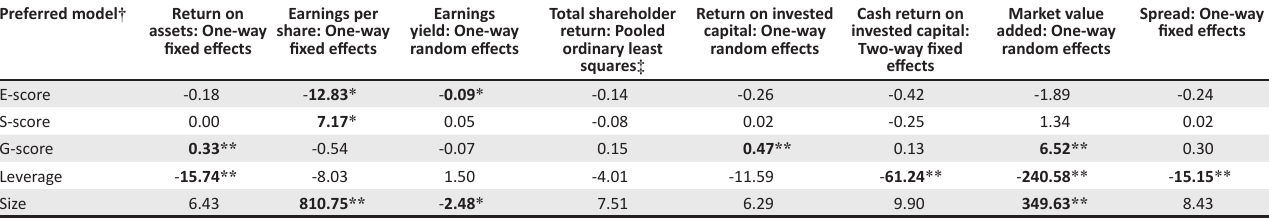
TABLE 4: Regression results for the individual environmental, social and corporate governance disclosure scores for the consumer goods sector. Preferred model